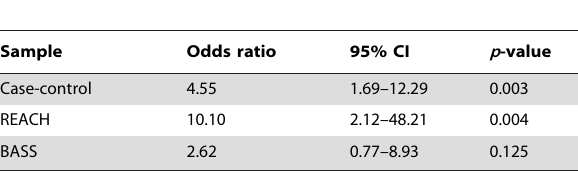
Table 2. Association of African ancestry and asthma using logistic regression models.